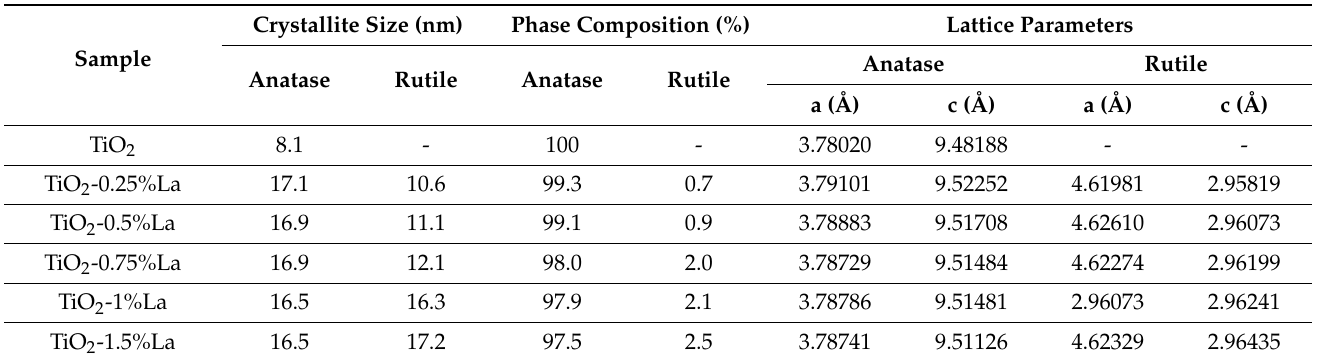
Table 2. The average crystallite size, phase composition, and lattice parameters of the obtained TiO 2 -La